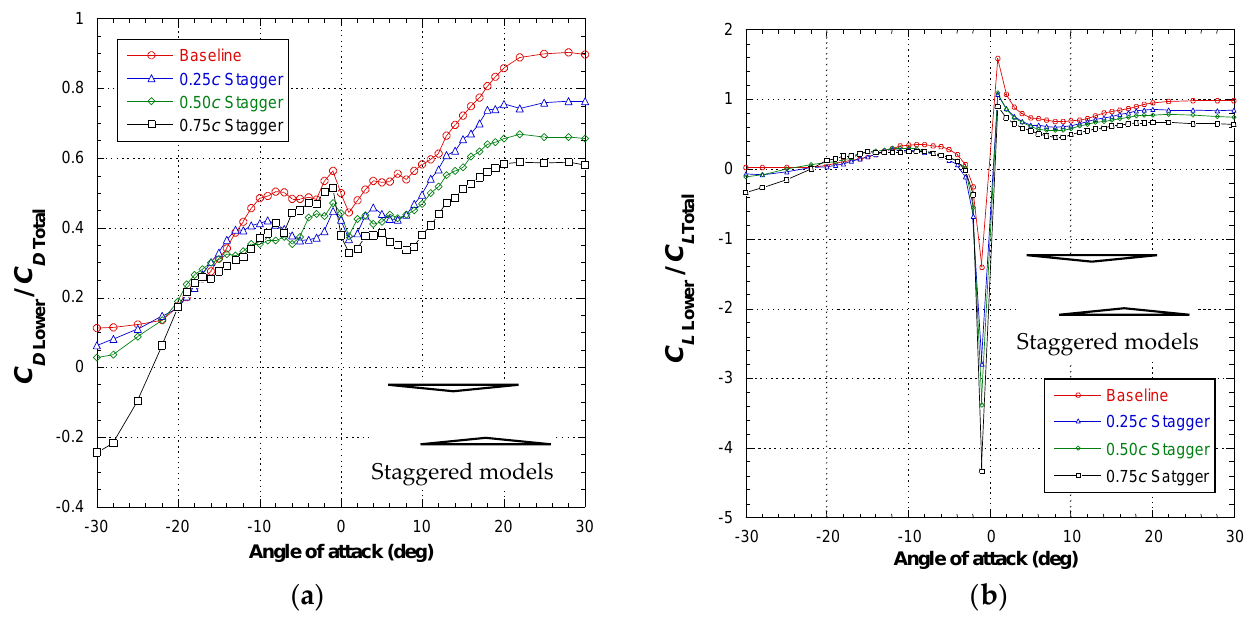
Figure 9. Ratios of the lower wing to the biplane performances: ( a ) ratio for drag coefficient; ( b ) ratio for lift coefficient.